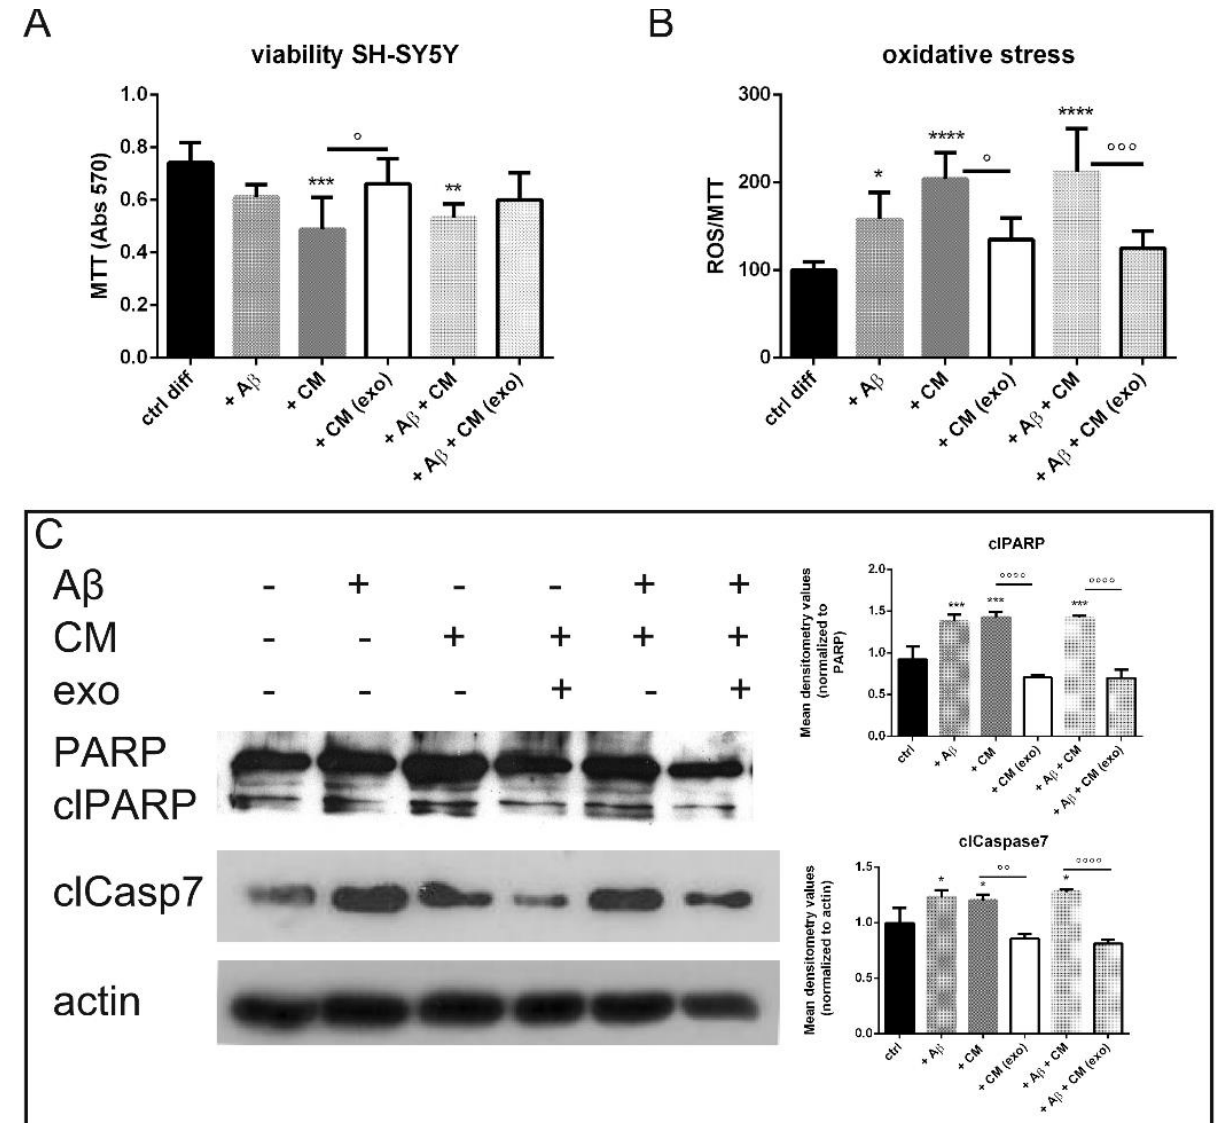
Figure 4. Indirect effect of hAFSC-exo on SH-SY5Y viability. ( A ) Graph of MTT assay of neuron cells exposed to BV-2 CM and/or A β in presence or absence of exo. ◦ p = 0.024; ** p = 0.009; *** p = 0.002. ( B ) Graph of ROS content normalized to MTT in neuron cells exposed to BV-2 CM and/or A β in presence or absence of exo. * p = 0.027; ◦ p = 0.011; ◦◦◦ p = 0.0004; **** p -value < 0.0001. ( C ) Representative WB experiment performed on SH-SY5Y exposed to BV-2 CM pretreated or not with exo. The graphs represent the mean ± SD of densitometric analysis of 3 experiments normalized to actin values. PARP: A β *** p = 0.0003; CM *** p = 0.0001; A β + CM *** p = 0.0001; ◦◦◦◦ p < 0.0001. Caspase7: A β * p = 0.014; CM * p = 0.035; A β + CM * p = 0.012; ◦◦ p = 0.0011; ◦◦◦◦ p < 0.0001.